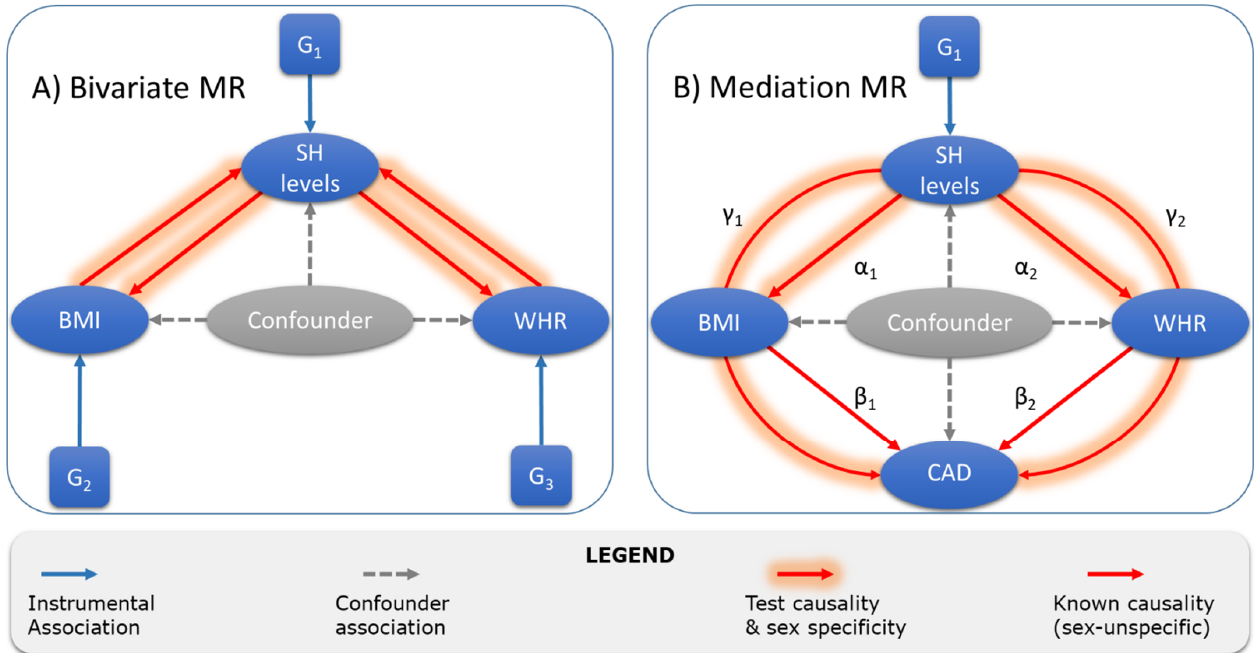
Figure 1. Overview of Mendelian randomization and mediation analyses of the present study. After the identification of valid instruments G 1 for steroid hormones (SH), we performed two MR analyses. ( A ) First, we conducted bivariate MRs testing causality between SH and the two obesity traits, BMI and WHR. Sex-specific summary statistics and instruments for BMI and WHR were taken from Pulit et al. [13] (G 2 and G 3 ). ( B ) Then, we tested for direct (not shown) and indirect effects ( γ i ) of SH on CAD using causal effect estimates of SH on BMI and WHR ( α i ) and of BMI and WHR on CAD ( β i , taken from Zhang et al. [20]). CAD summary statistics were obtained from van der Harst et al. [1] (sex-unspecific).